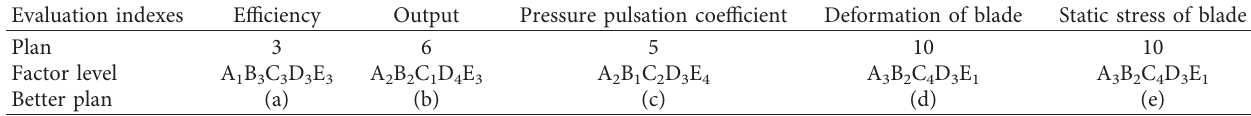
Table 7: Intuitive analysis of the better